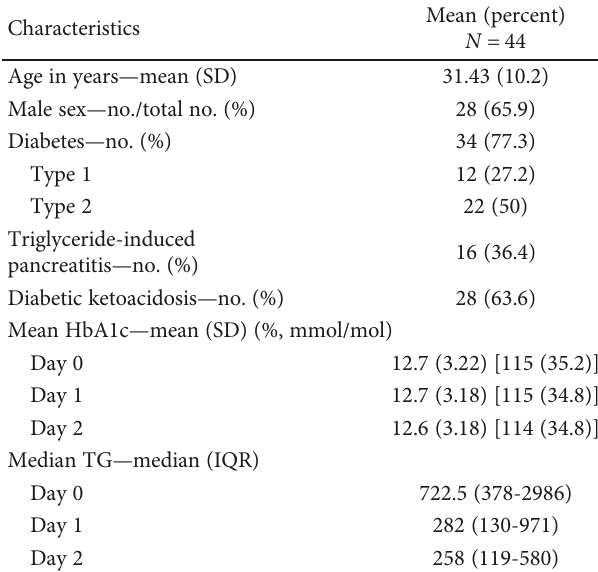
Table 1: Demographic characteristics.